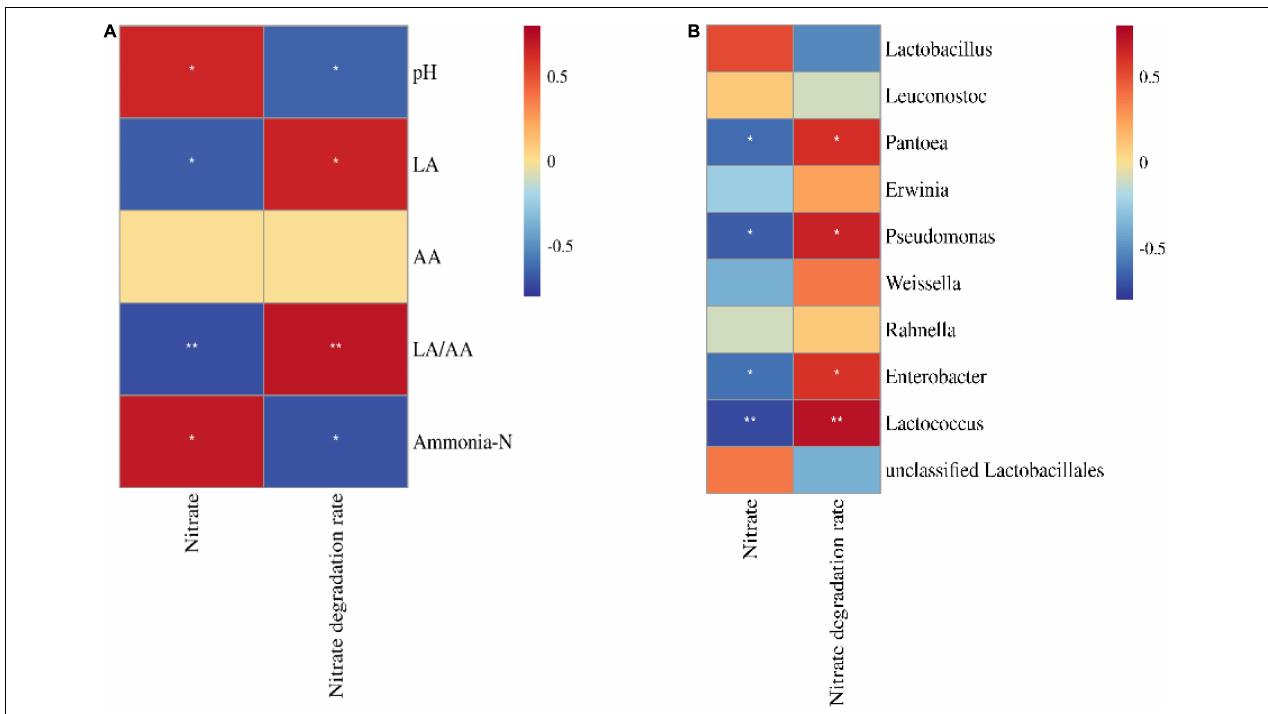
FIGURE 4 | Correlation heatmap of nitrate and nitrate degradation rate with fermentation parameters (A) and the bacterial community (top 10 bacterial genera, B ) ( n = 12). LA, lactic acid; AA, acetic acid. * p < 0.05; ** p <